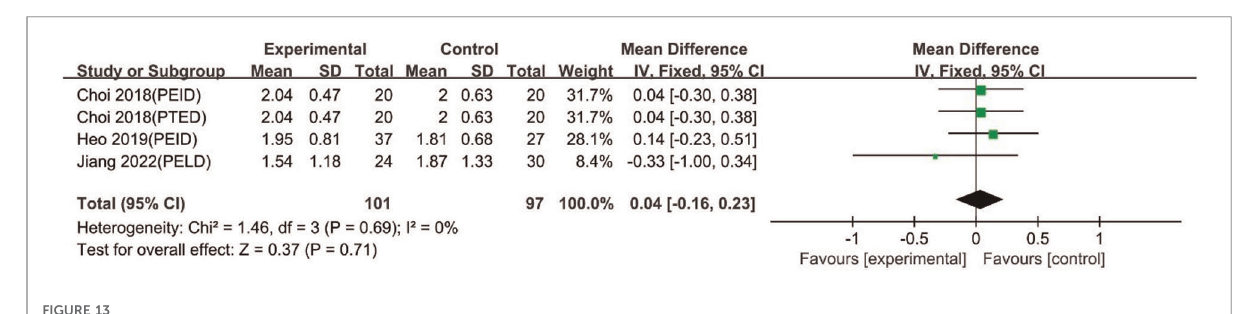
FIGURE 13 Forrest plot of vas back pain 1-day UBE vs